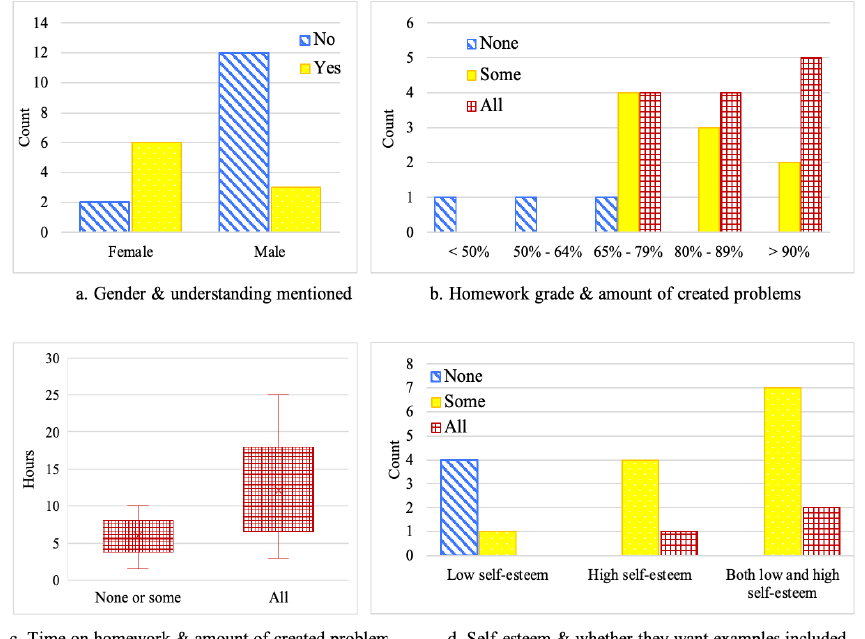
Fig. 3. Inferential analyses by independent